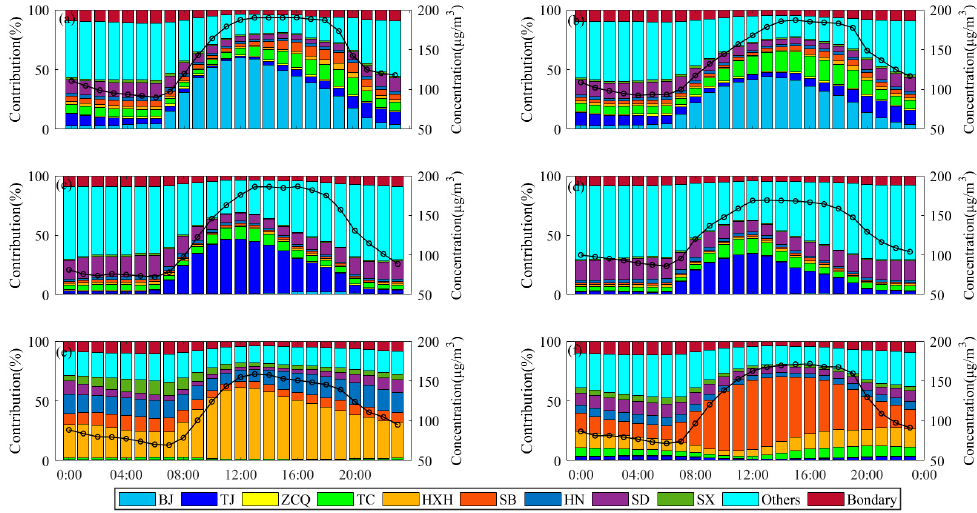
Figure 9. Diurnal variation in O 3 concentration (black lines with circles, right axis) and its source apportionment by region (bars, left axis) at 6 sites; ( a – f ) represent the observation sites BJ_1, BJ_2, TJ_1, TJ_2, HB_1, and HB_2, respectively.